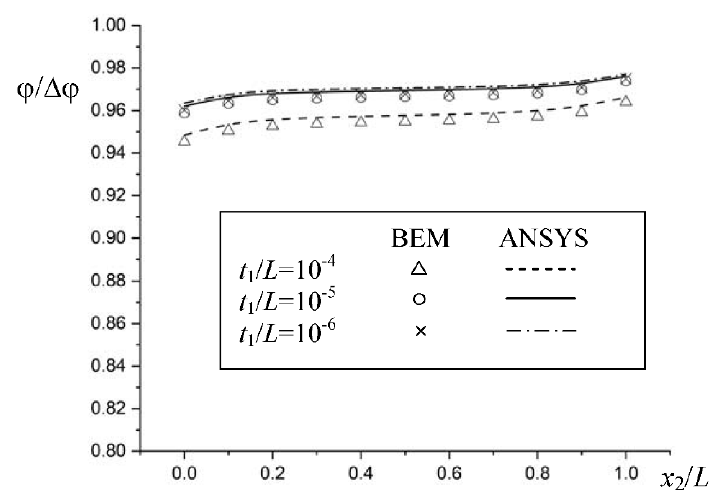
Figure 6. Normalized temperature distribution along A - A′ for the example.